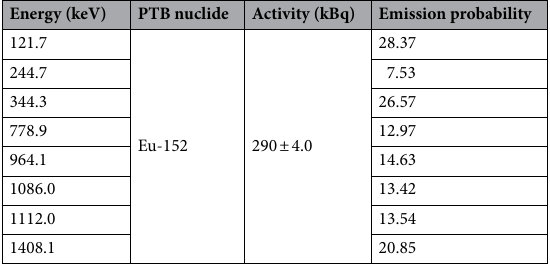
Table 2. The characteristic of Eu-152 radioactive point source.